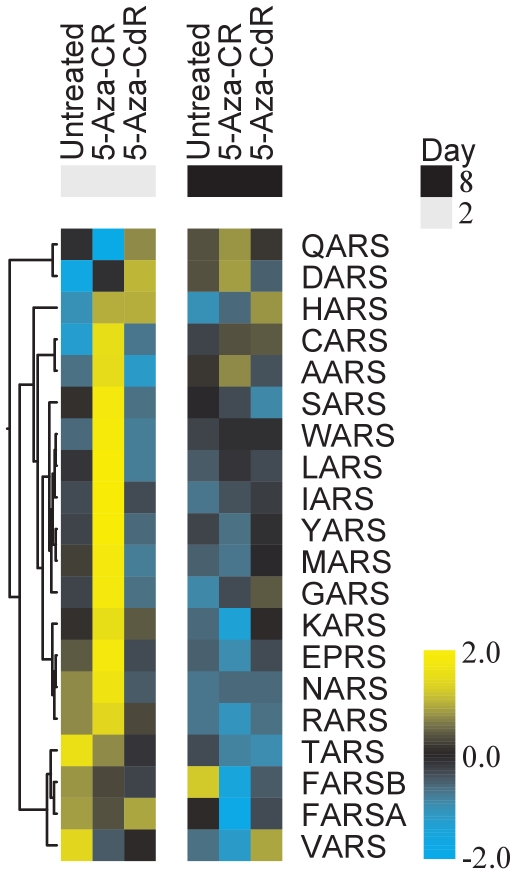
Hierarchical clustering showing differential expression of tRNA synthetase genes.Heatmap of the linear fits from the Limma analysis, showing tRNA synthetase genes primarily upregulated in 5-Aza-CR treated T24 cells on day 2.